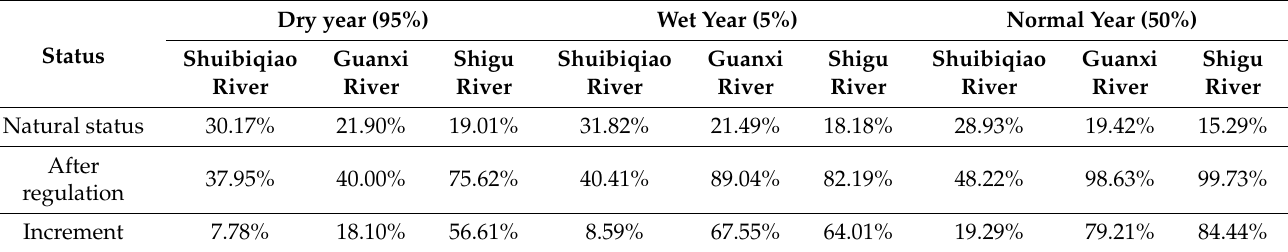
Table 6. Ecological flow assurance rate comparative analysis